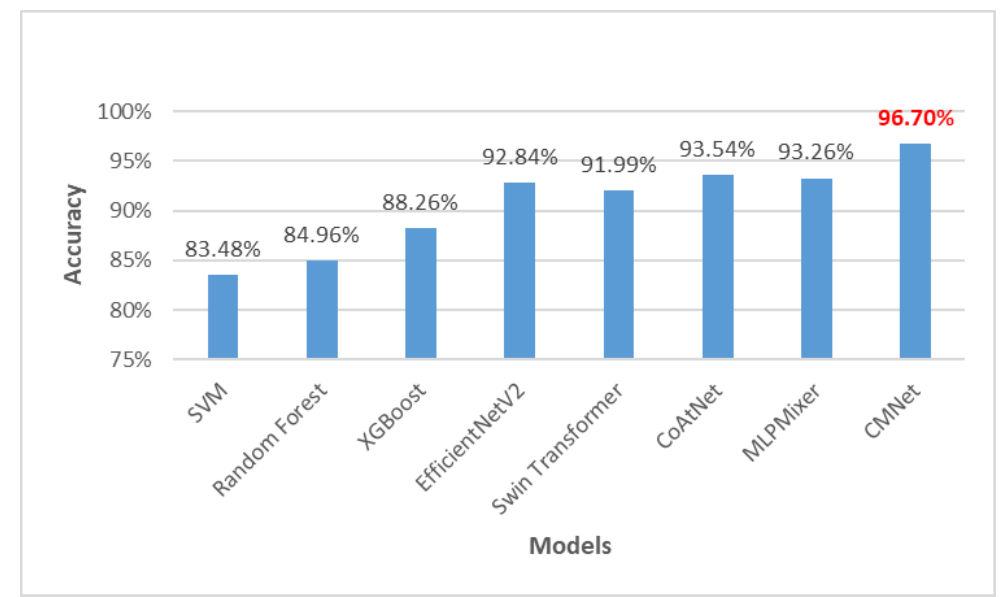
Figure 9. Comparison of performance between this study and other